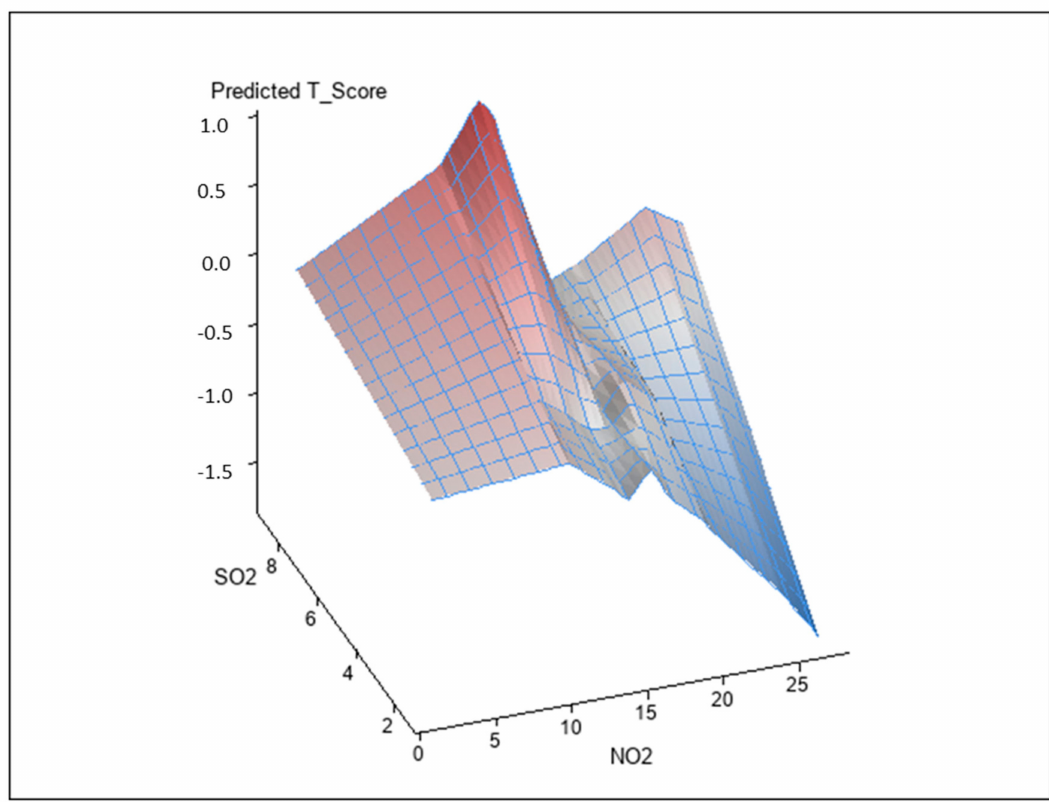
Figure 3. Synergistic e ff ect of SO 2 and NO 2 on BMD T-score. The interaction between SO 2 and NO 2 on BMD T-score was statistically significant ( p =